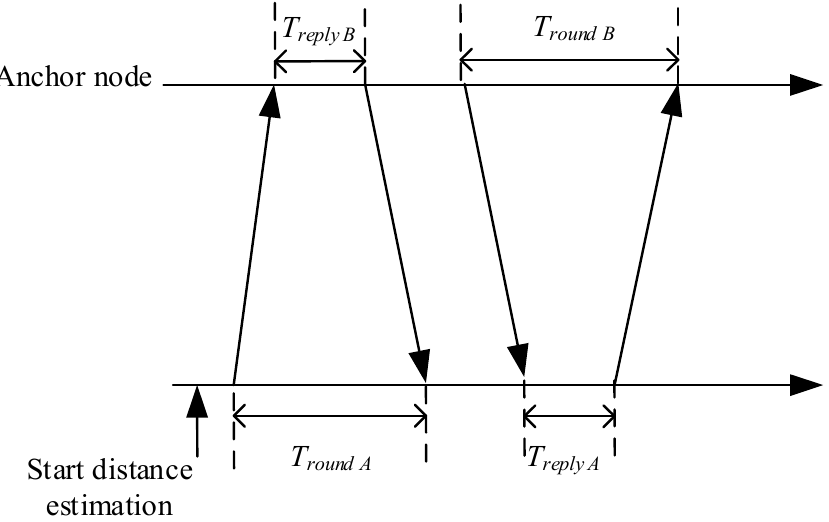
Figure 2. The procedure of DS-TWR distance estimation. DS-TWR distance estimation method adds another communication based on SS-TWR distance estimation method, and the time of two communications can make up for the error caused by clock offset. The distance estimation between the anchor node and mobile node can be calculated using the Equation (1). In this equation, propagation delay from one node to another node, and v processing delay of the anchor node. denotes the propagation velocity of radio signal.